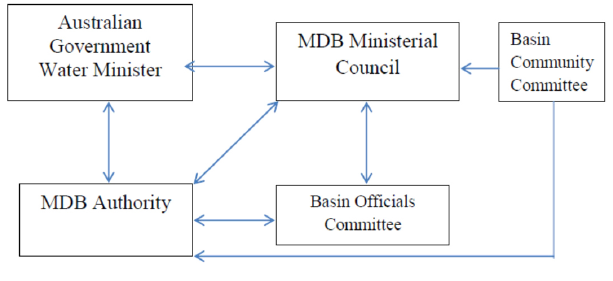
Fig. 3 . The Murray-Darling Basin (MDB) organization after